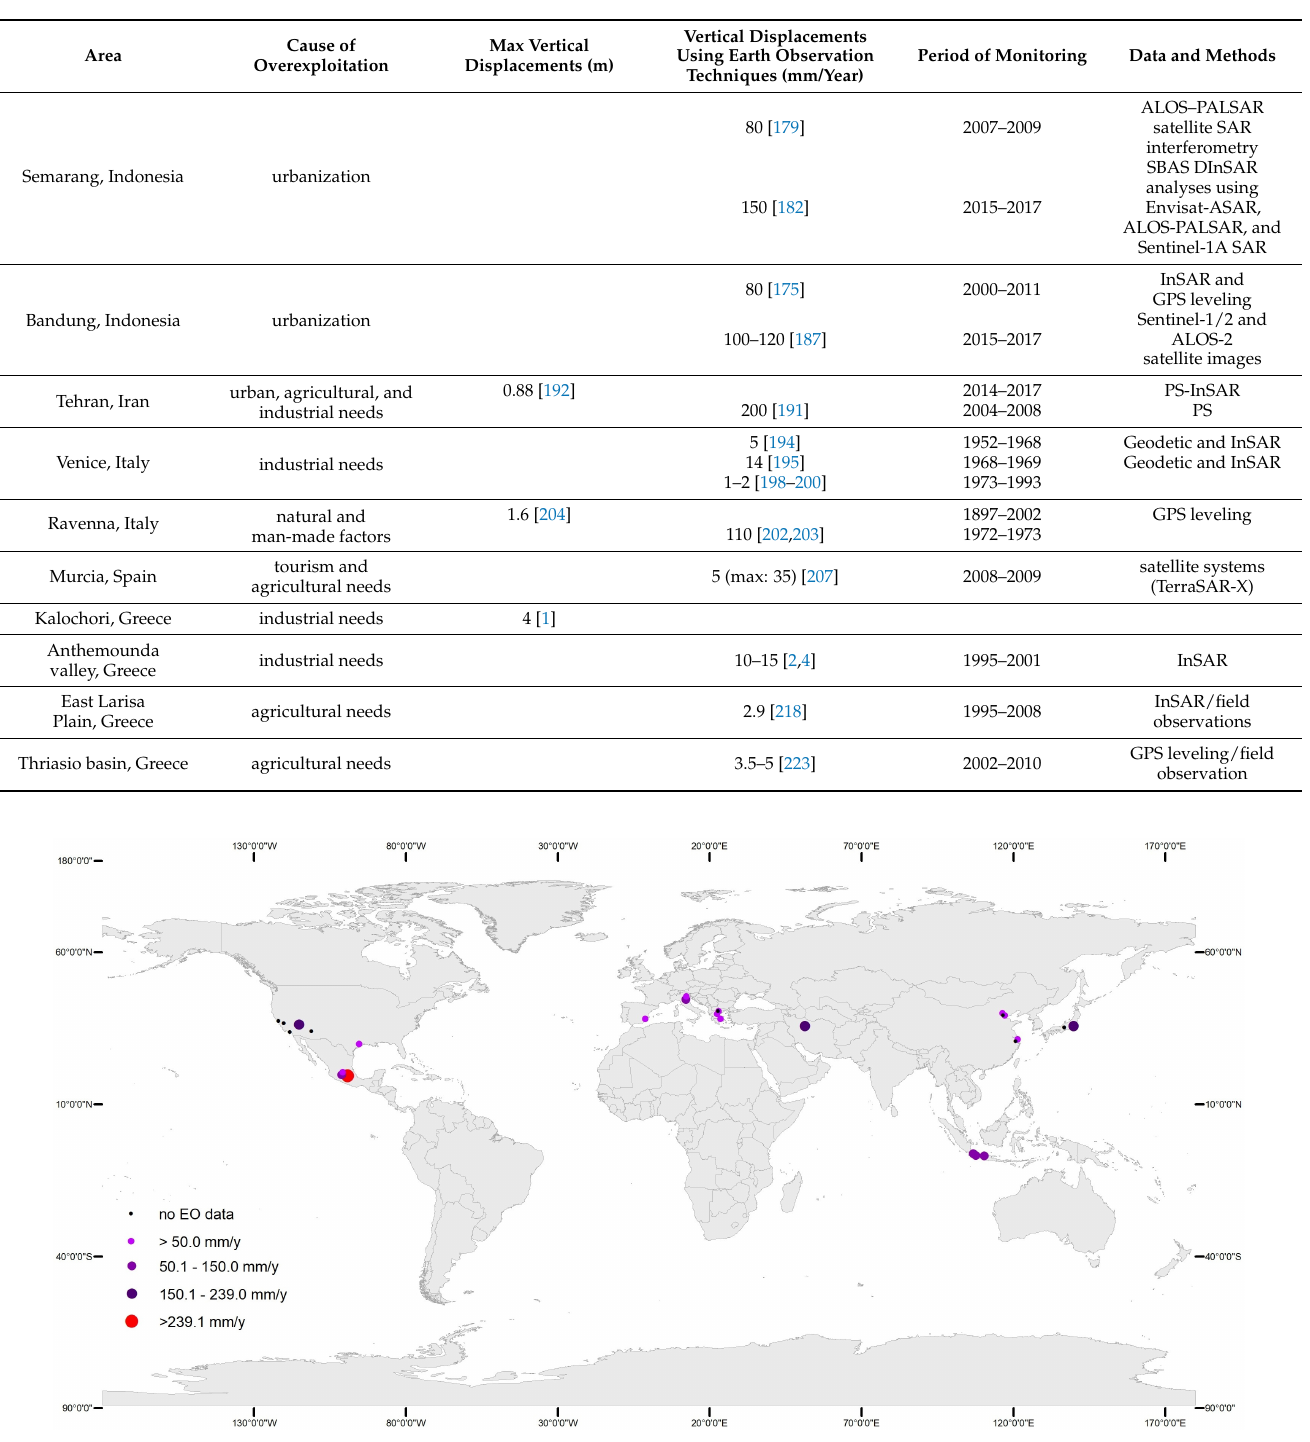
Figure 13. Geographic distribution of the data (Vertical displacements using Earth Observation techniques (mm/year))